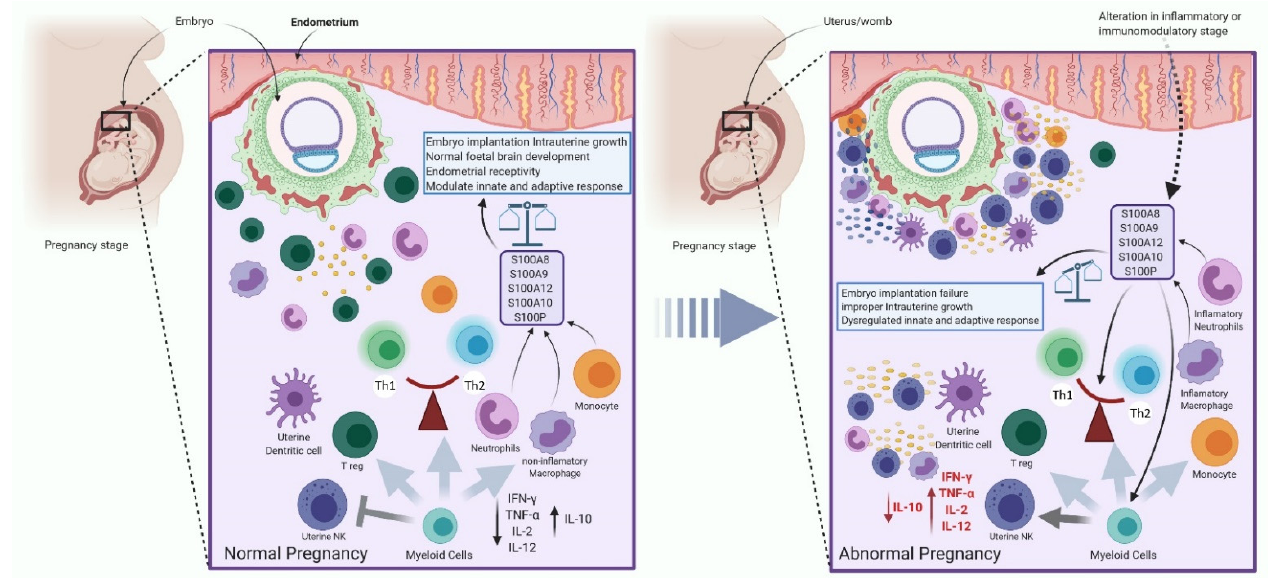
Figure 8. The interaction of S100 proteins with immune cells to control different characteristic stages of pregnancy is depicted in this diagram. TNF- α , tumor necrosis factor-alpha; uNK, natural uterine killer; IFN- γ , interferon-gamma; IL, interleukin; TH, T helper. Created with BioRender.com.